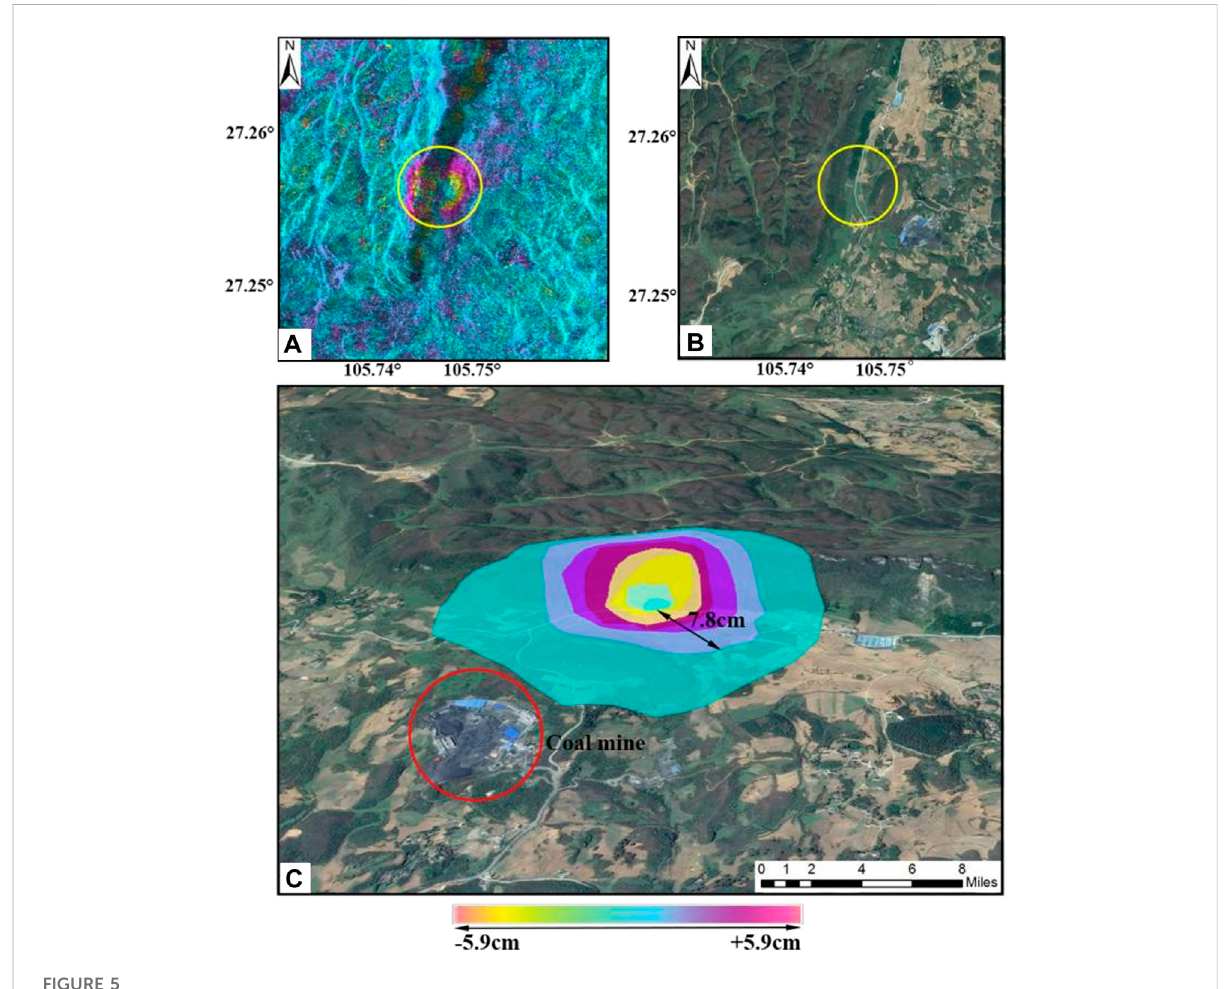
FIGURE 5 The DInSAR results of Shiping